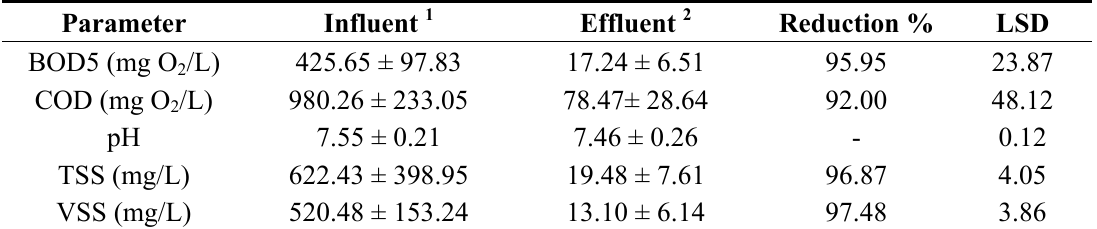
Table 1. Operational conditions in the submerged fixed-film bioreactor at bench scale during the experiments. Parameter Influent 1 Effluent 2